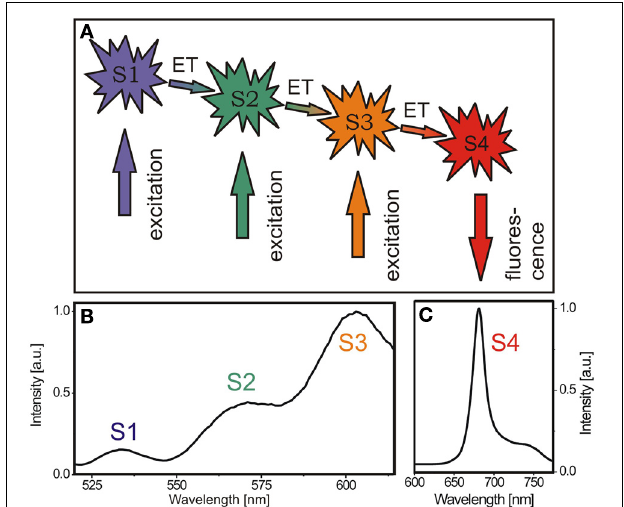
FIGURE 1 | Energy migration pathway in chloroplasts can be visualized by spatially resolved fluorescence excitation spectroscopy (FExS). (A) Energy migration scheme in chloroplasts. S1 to S3 indicate states in the LHC energy transfer cascade, from which excitation energy is transferred downstream to the reaction center (S4). (B) Representative confocal fluorescence excitation spectrum of an A. thaliana chloroplast recorded by sweeping the excitation wavelength while recording the fluorescence intensity at 680nm. (C) Typical chloroplast fluorescence emission spectrum of an A. thaliana chloroplast excited at